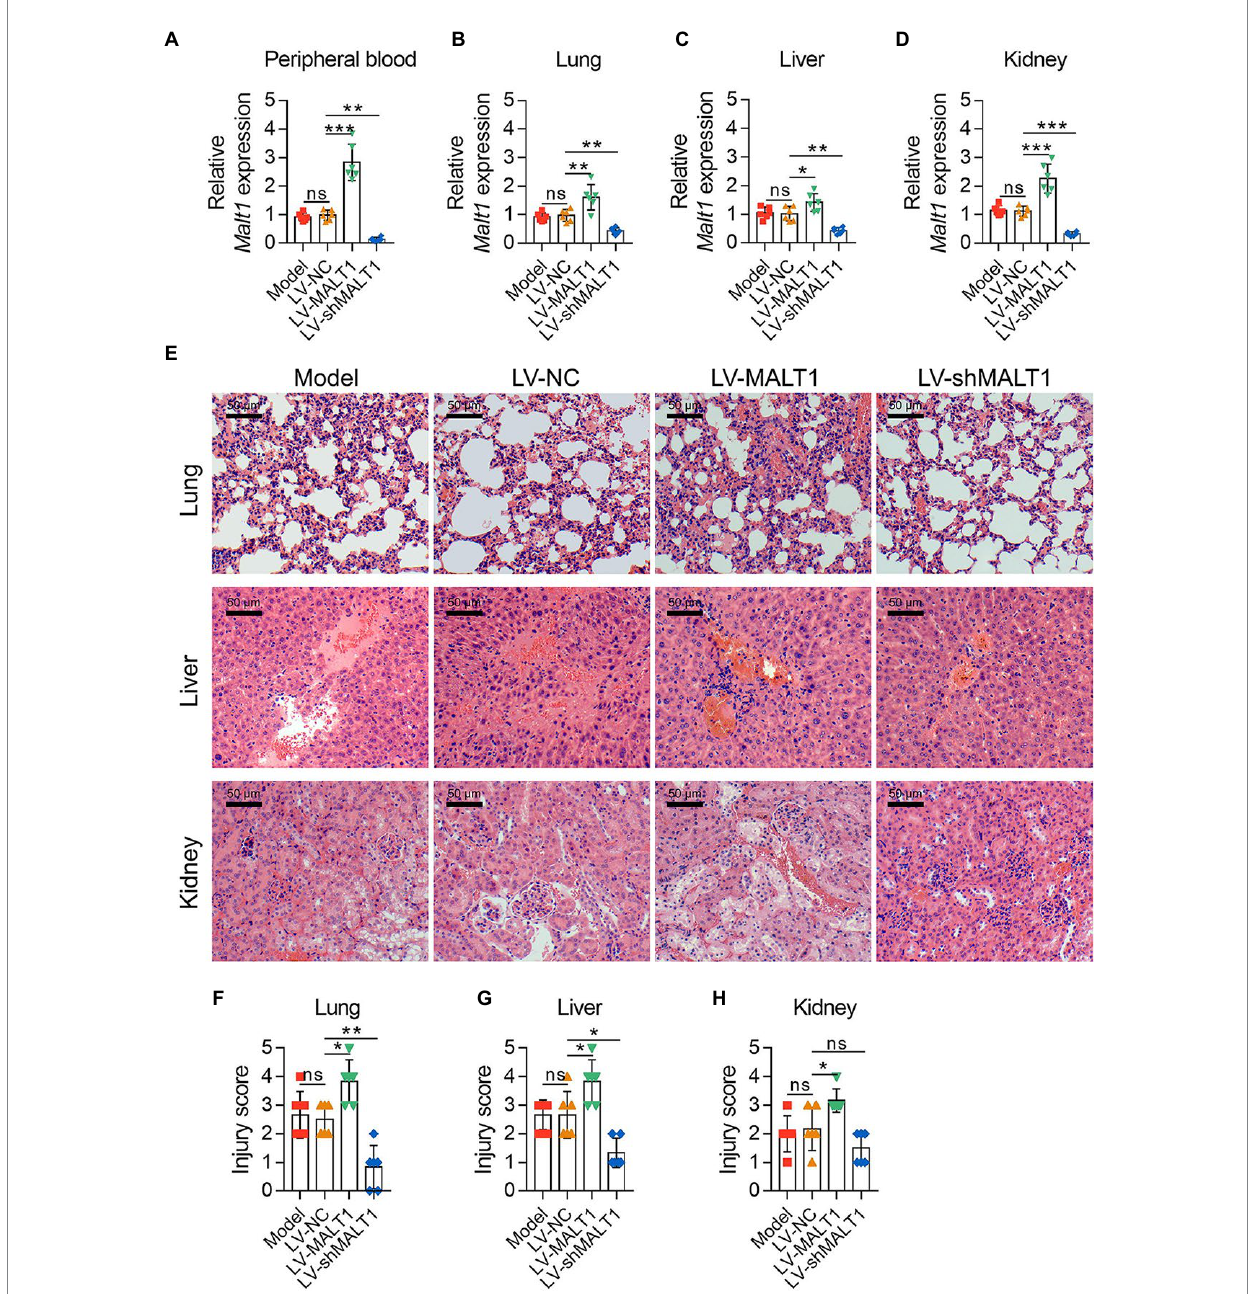
FIGURE 2 Effect of MALT1 on tissue injury in LPS-induced septic mouse model. Comparison of Malt1 expression in peripheral blood (A) , lung (B) , liver (C) , and kidney (D) among the Model, LV-NC, LV-MALT1, and LV-shMALT1 groups. HE analysis of lung, liver, and kidney tissues among the Model, LV-NC, LV- MALT1, and LV-shMALT1 groups (E) . Comparison of injury scores of the lung (F) , liver (G) , and kidney (H) among the Model, LV-NC, LV-MALT1, and LV-shMALT1 groups. n = 6 in each group. One-way ANOVA plus Tukey’s post hoc test was applied. Ns, not significant; * p < 0.05; ** p < 0.01; *** p <